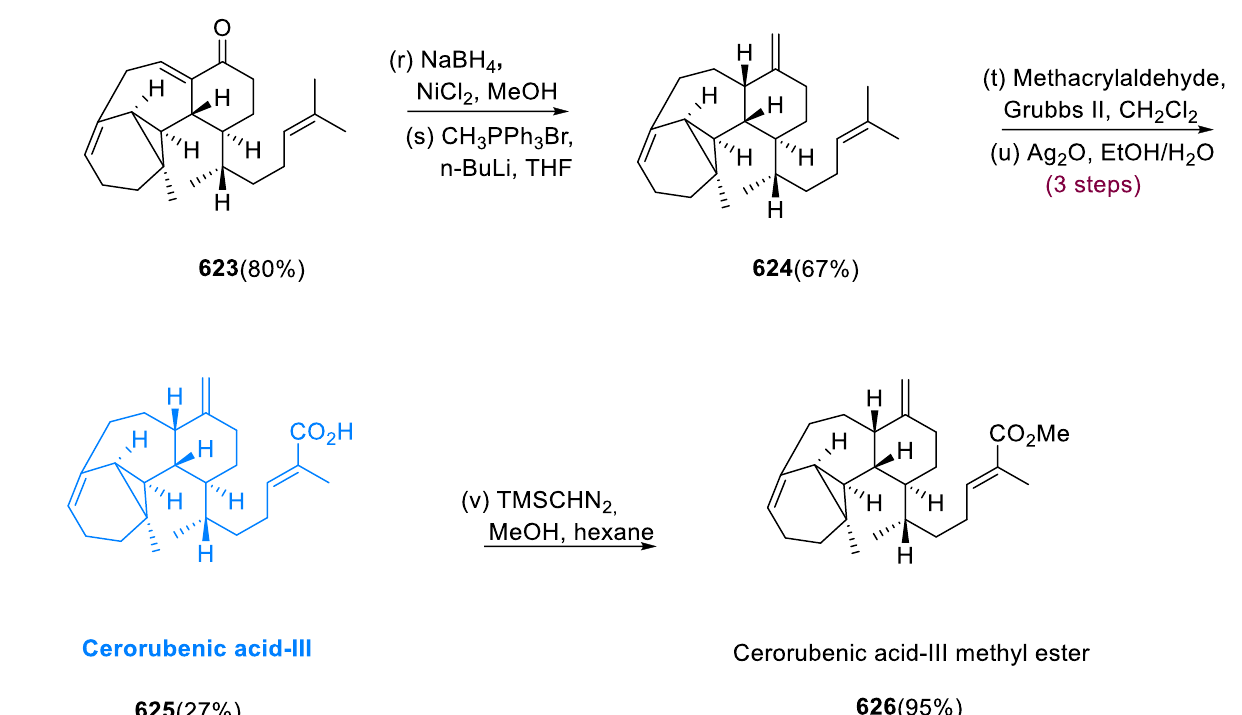
Scheme 36. Total synthesis of cerorubenic